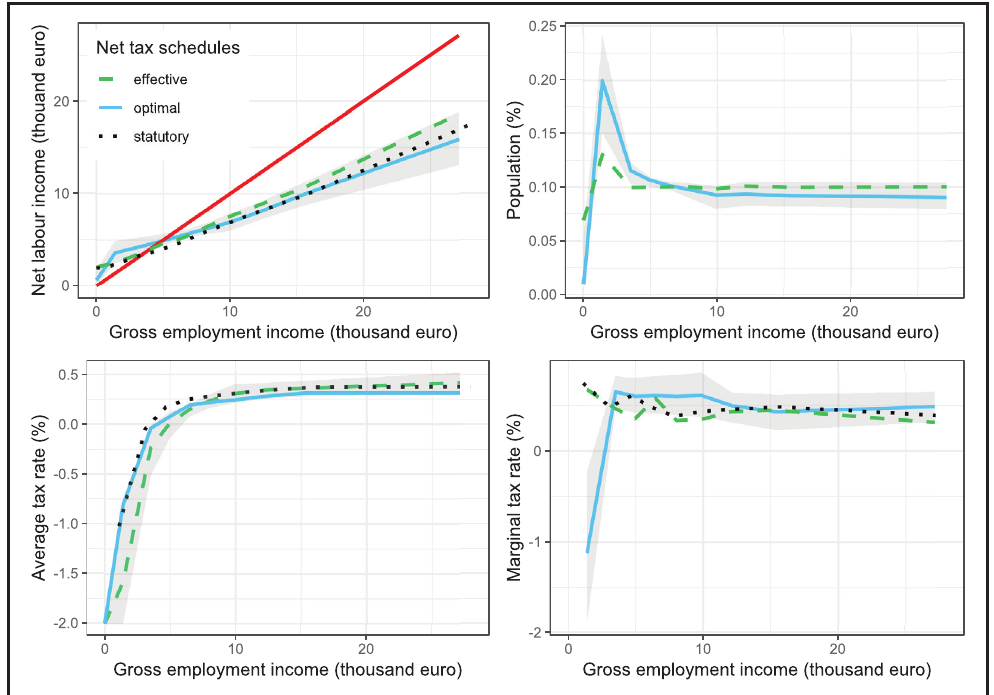
Optimal, effective, and statutory net tax